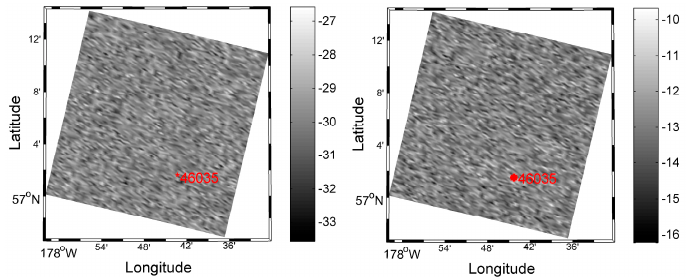
Figure 4. RADARSAT-2 SAR image of the Bering Sea at 03:52:26 on 9 January 2012 showing VH polarization ( left ) and VV polarization ( right ). The location of NDBC buoy 46,035 is indicated.